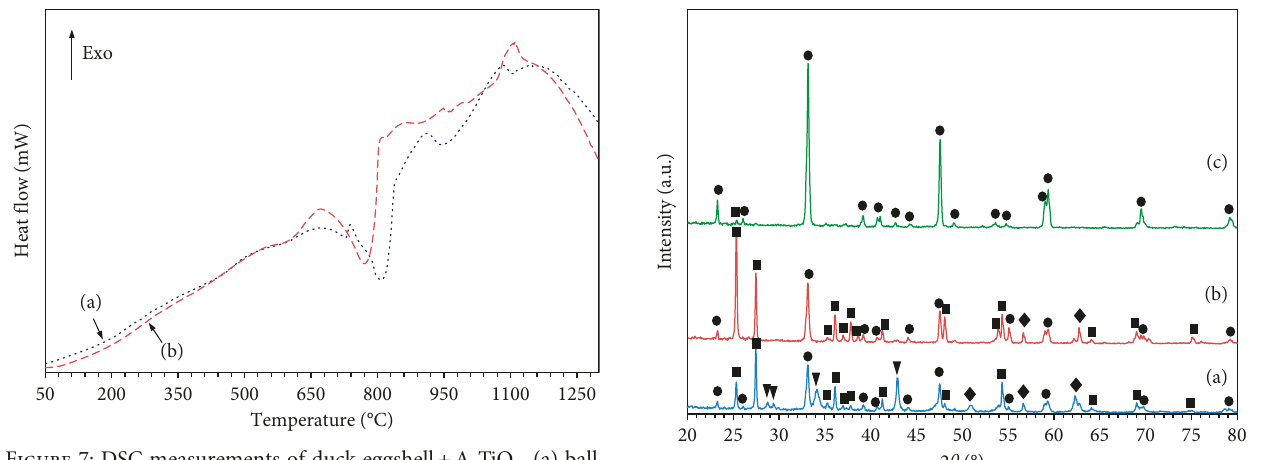
2 . (a) ball- Figure 8: XRD patterns of the powder products synthesized in air (a) as-combusted product (ball-milled), (b) as-leached product from 30min high-energy-milled duck eggshell+A-TiO 2 /Mg, and (c) as- leached product from 30min ball-milled duck eggshell+A-TiO 2